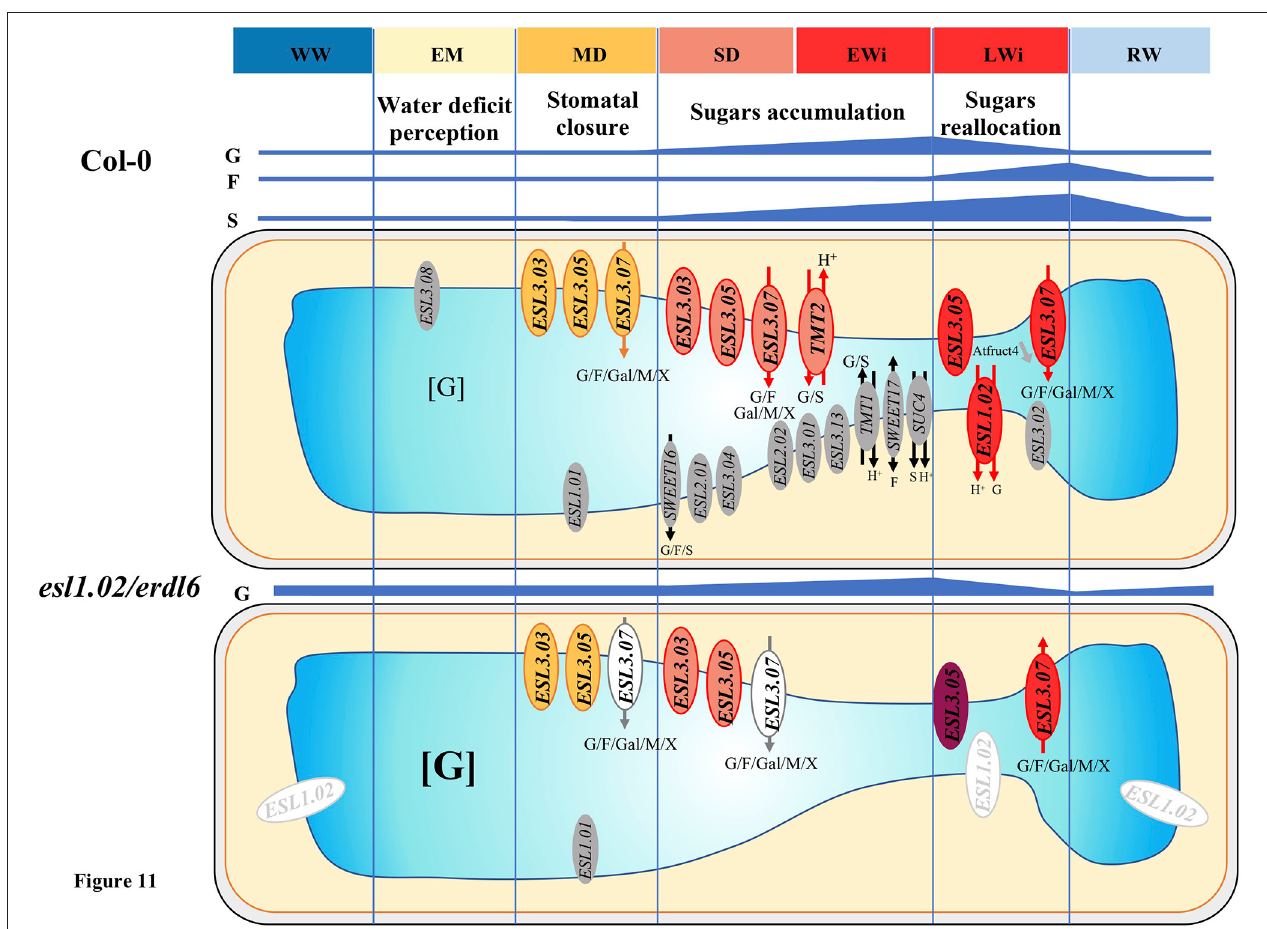
FIGURE 11 | Summary of the evolution of the sugar content and of the expression of vacuolar SUTs in the leaves of A. thaliana Col-0 and esl1.02/erdl6 mutant, under water deficit. WW means well-watered condition (control); water deficit is split into different phases (EM, early mild water deficit; MD, moderate water deficit; SD, severe water deficit; EWi, early wilting; LWi, late wilting). RW means re-watering. G, F, S, Gal, M, and X stand for glucose, fructose, sucrose, galactose, mannose, and xylose. Gray color indicates repressed transporters; orange, light, and dark red indicate different levels of induction. In esl1.02/erdl6 , the induction of ESL3.07